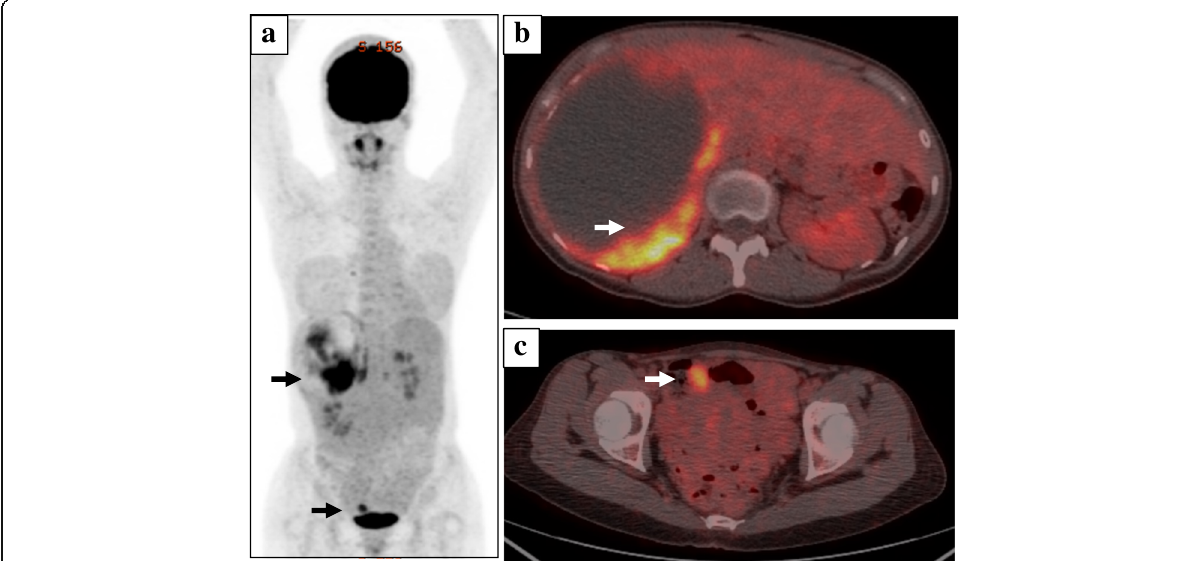
Fig. 2 Findings of FDG-PET. a The fusion image of FDG-PET shows abnormal accumulation in the liver and lower abdomen ( black arrows ). b Cross-section of the upper abdomen indicates abnormal accumulation in the mural nodule in the liver ( white arrow ). c Cross-section of the lower abdomen indicates abnormal accumulation of the omental tumor ( white arrow